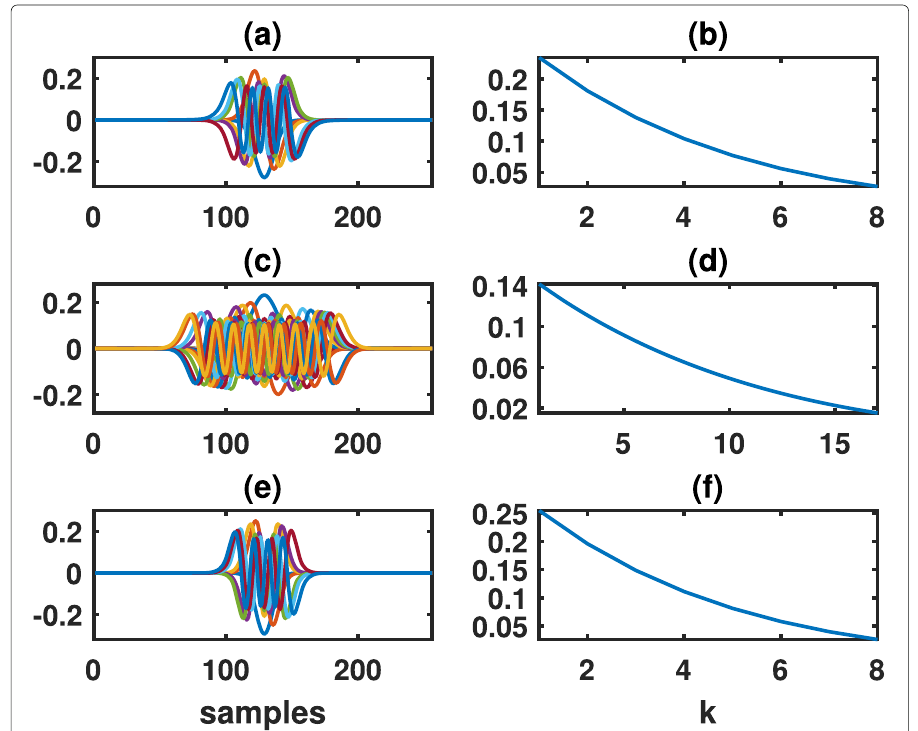
Fig. 10 Example of LSP-based MSE optimal multitapers and weights for a random set of realizations from the three categories: a multitapers and b weights for “Faces,” c multitapers and d weights for “Objects,” and e multitapers and f weights for “Landmarks”